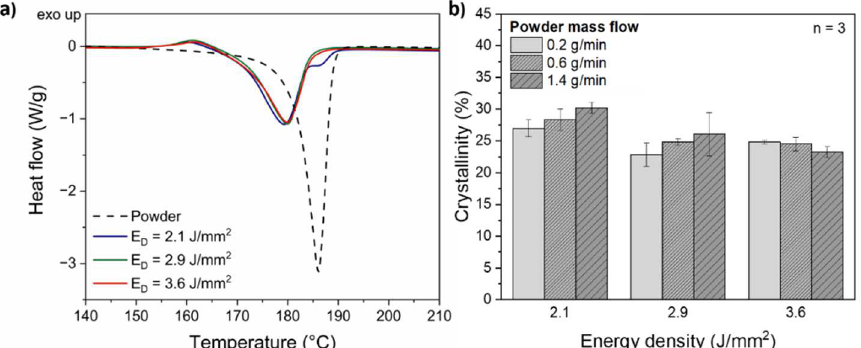
Figure 4. ( a ) Representative DSC heating curves of PA12 powder and coatings applied by DED- LB/P with a constant powder mass flow of 0.6 g/min for energy densities of 2.1 J/mm 2 , 2.9 J/mm 2 and 3.6 J/mm 2 . The heating rate was 10 K/min; ( b ) crystallinity of the PA12 coatings as a function of the energy density and powder mass flow ( n = 3).